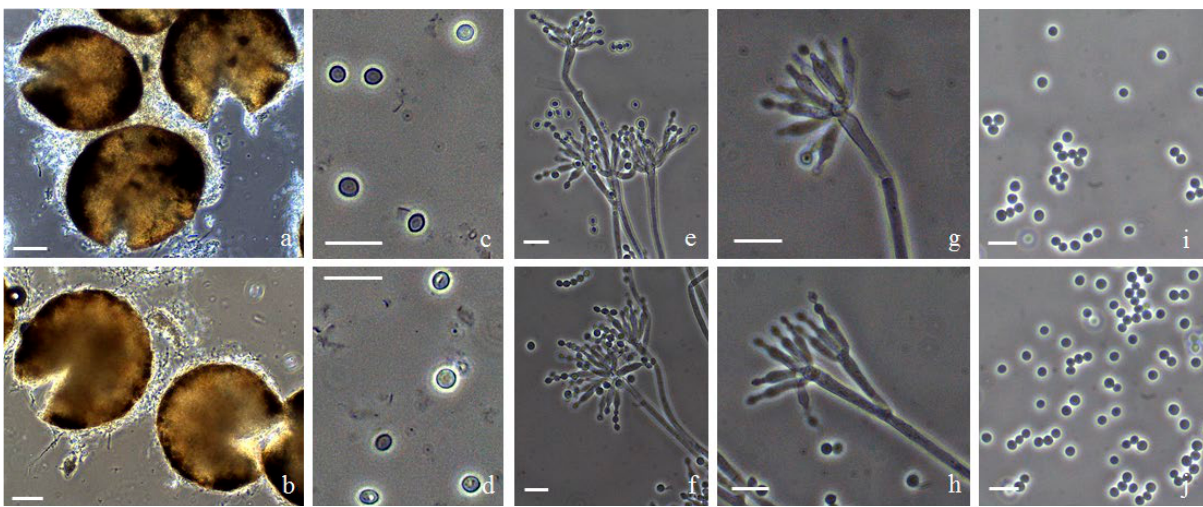
Figure 4. Micro-morphology of Penicillium fructuariae-cellae on CYA. Cleistothecia (a and b), ascospores (c and d), conidiophores (e to h), and conidia (i and j) of, respectively, ITEM 18277 (isolate Pdb1, top row) and ITEM 18276 T (isolate P3, bottom row). Bars = 50 μm (a and b), or 10 μm (c to